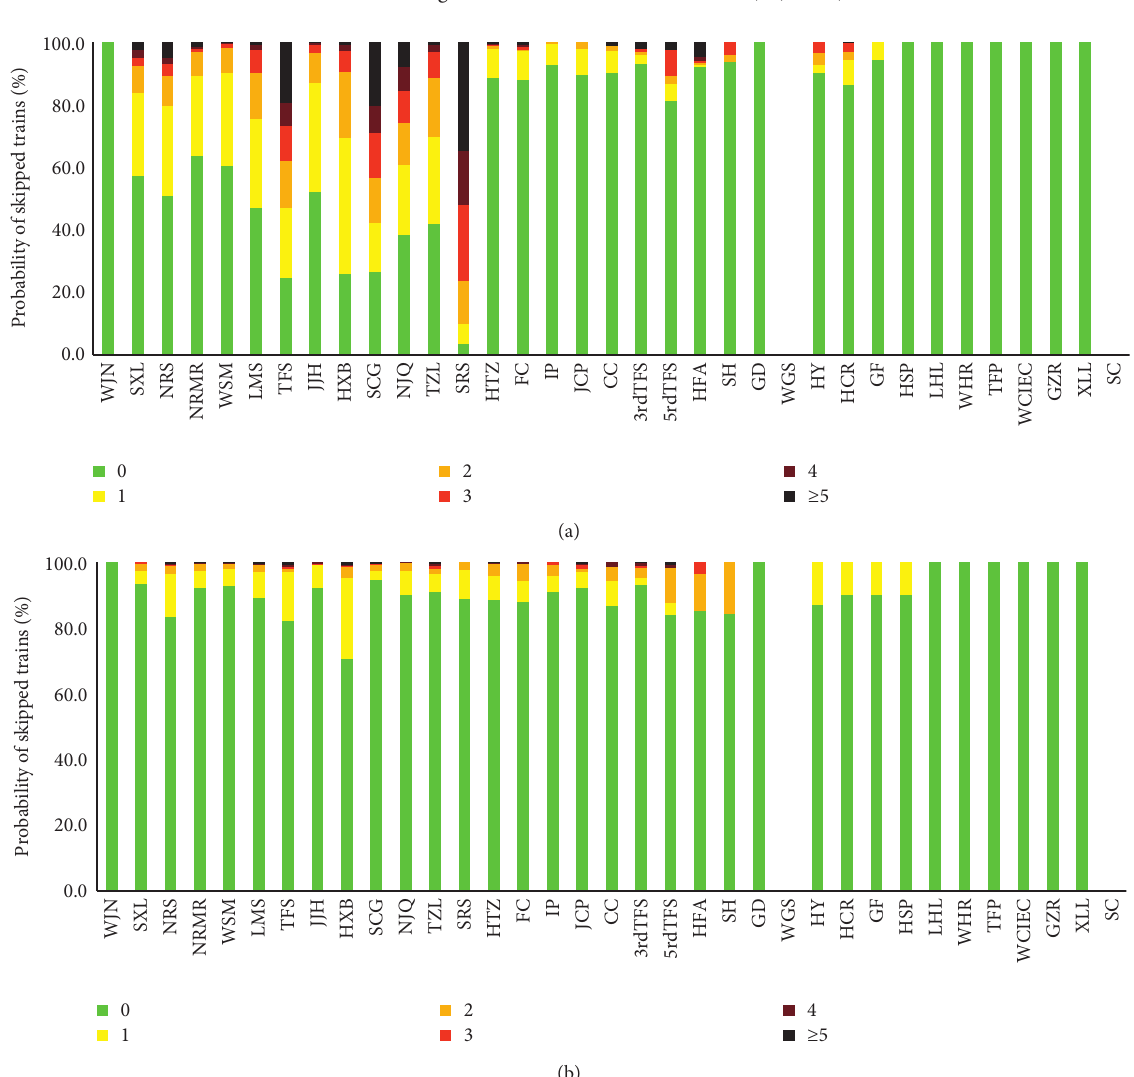
Figure 8: Average wait time at stations on line 1 (WJN-SC).